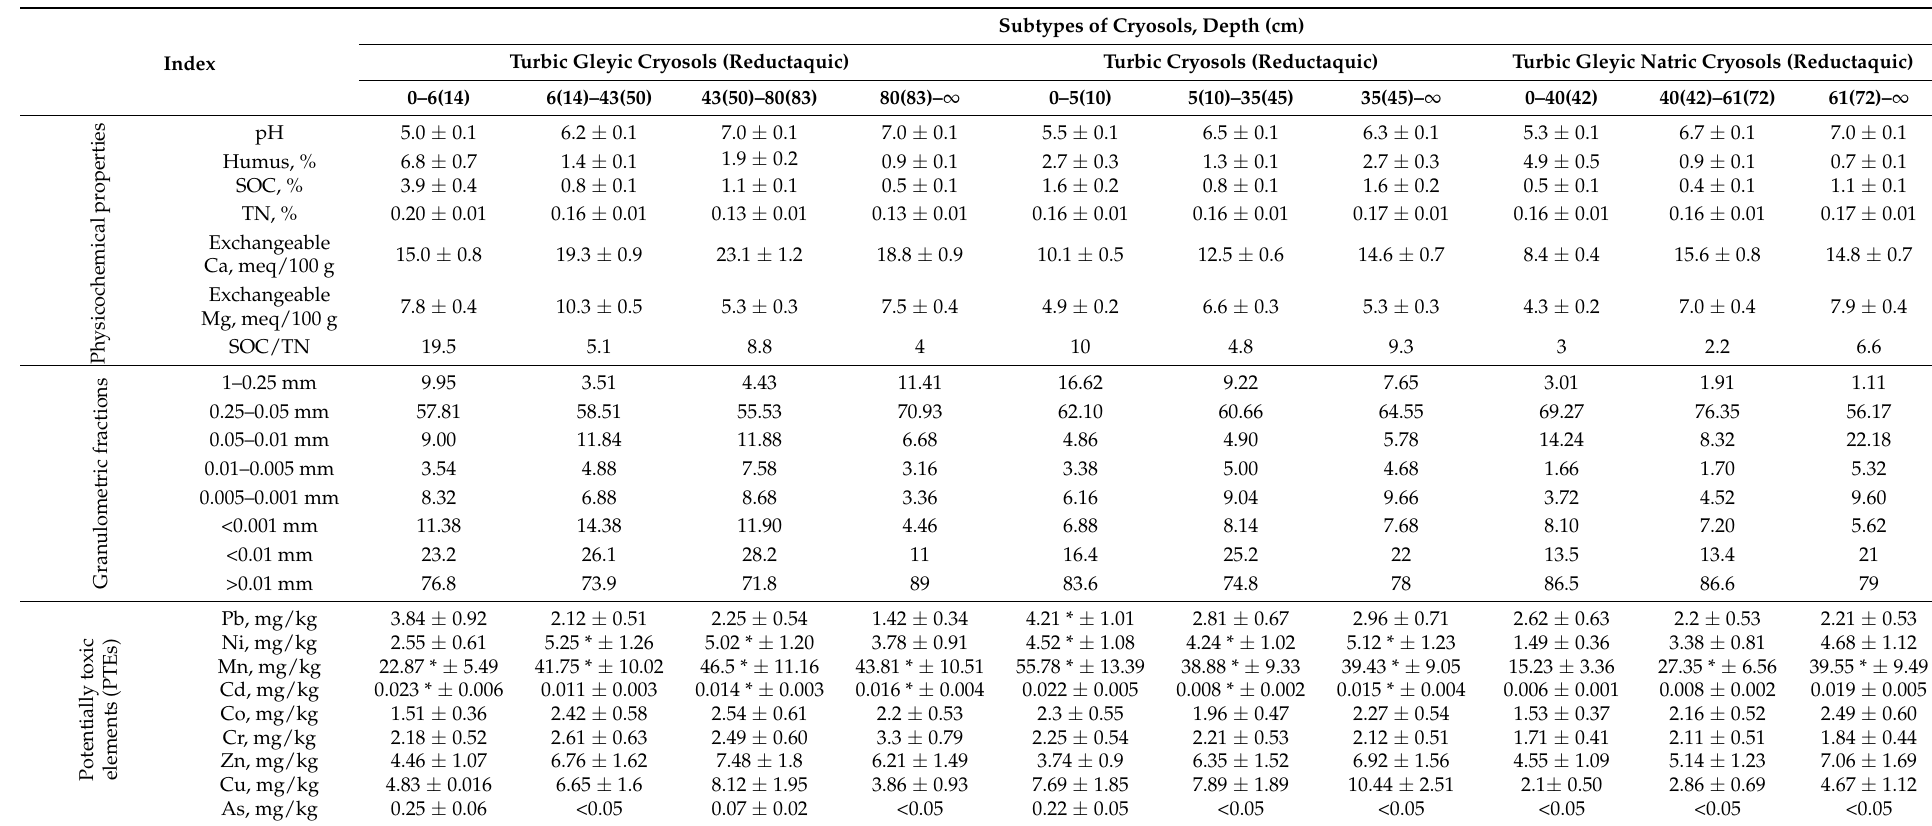
Table 1. Physicochemical and mobile forms of PTE characteristics of dominant subtypes of soils of the Khannya–Nakyn